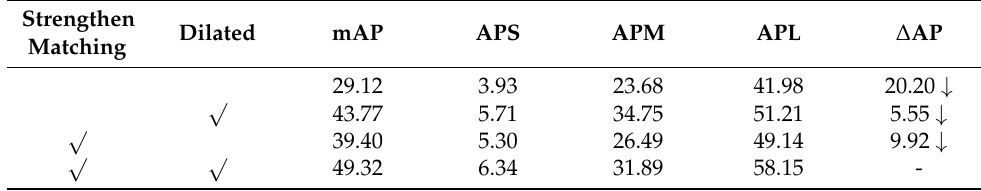
√ in the table represent use strengthen matching or dilated component. Method with both strengthen matching and dilated achieved the best preference. The difference between the controlled experiment and both used is indicated by ↓